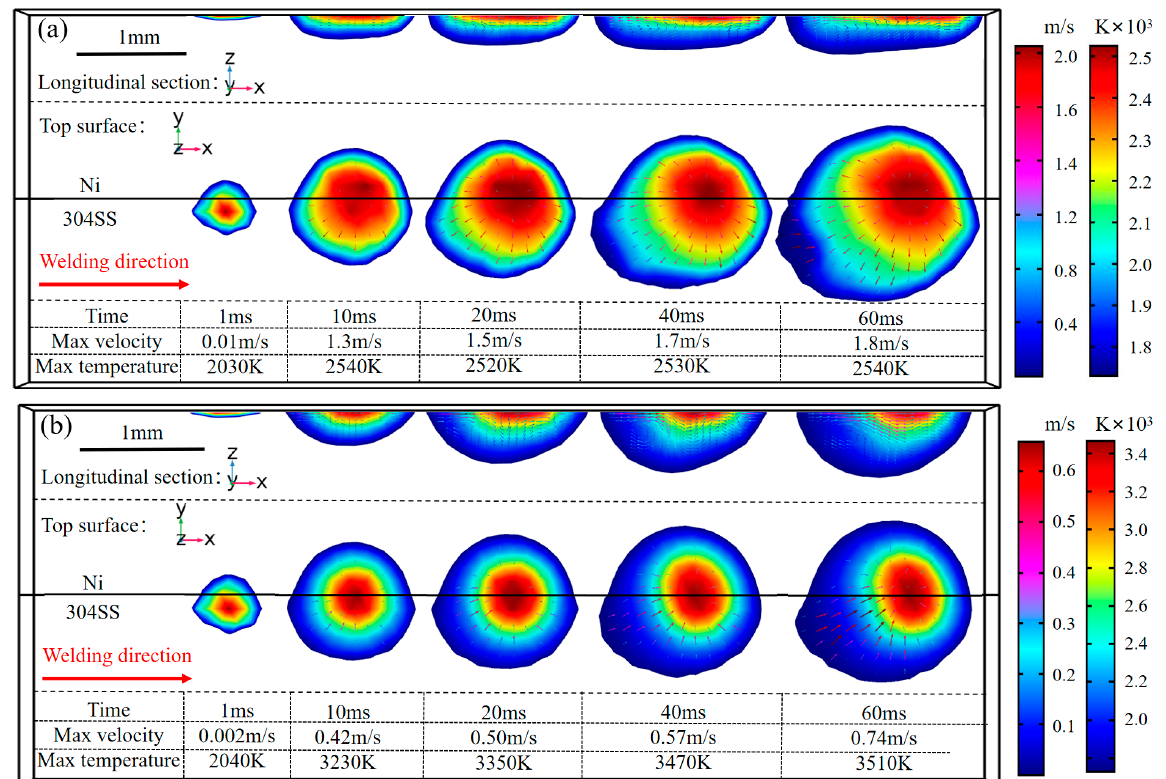
Figure 5. Evolution of temperature and fluid field for longitudinal section and top surface ( a ) in pure argon and ( b ) in the AMO.